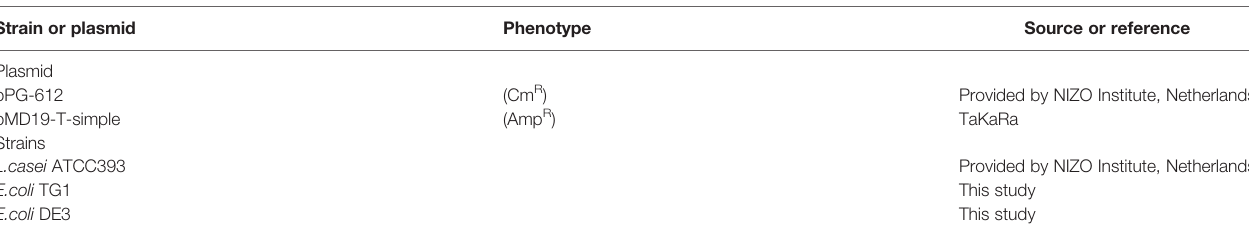
TABLE 1 | Strains and plasmids used in this